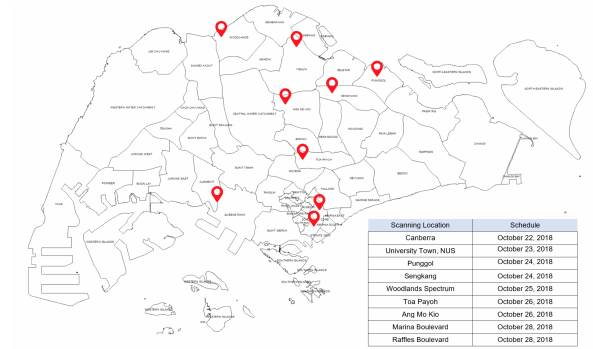
Figure 2. Map of case study areas for Pegasus:Stream.